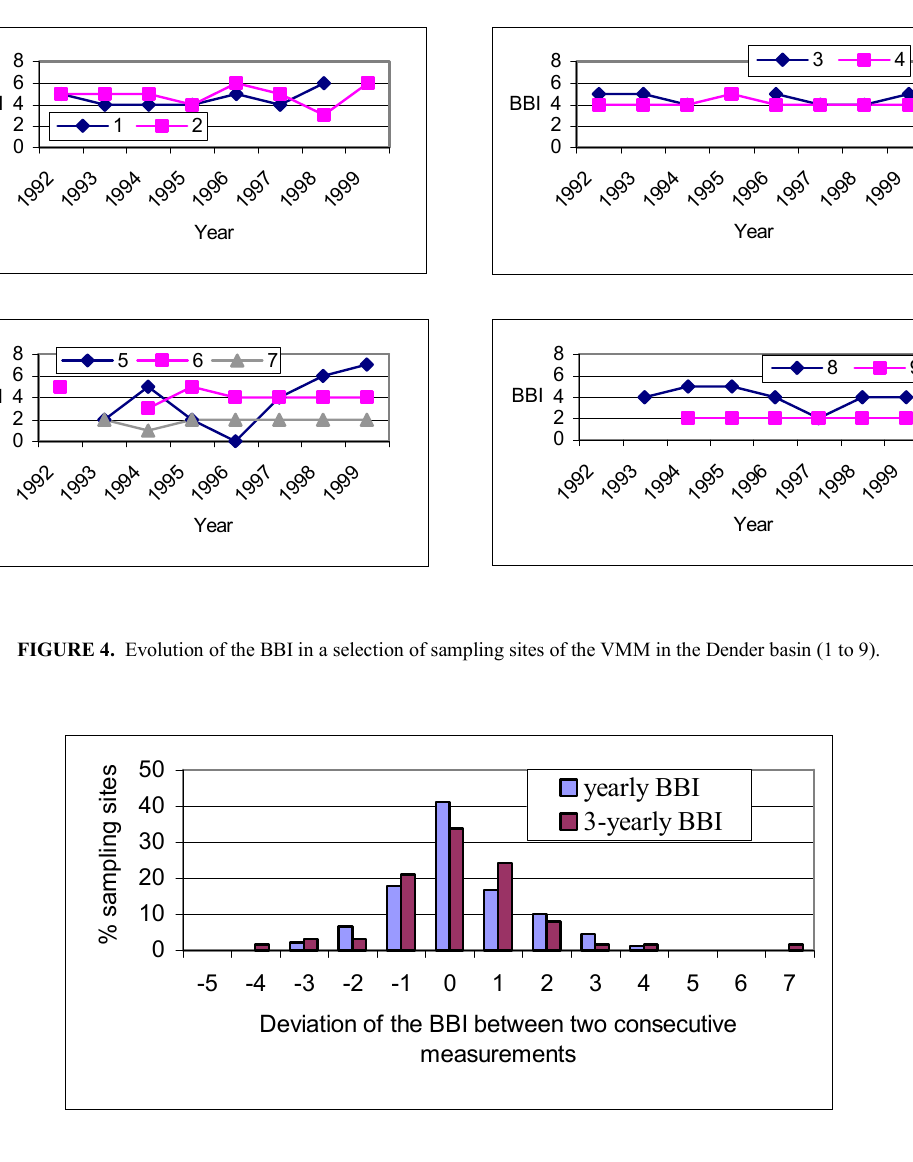
FIGURE 5. Influence of the monitoring frequency on the deviation between two consecutive BBI